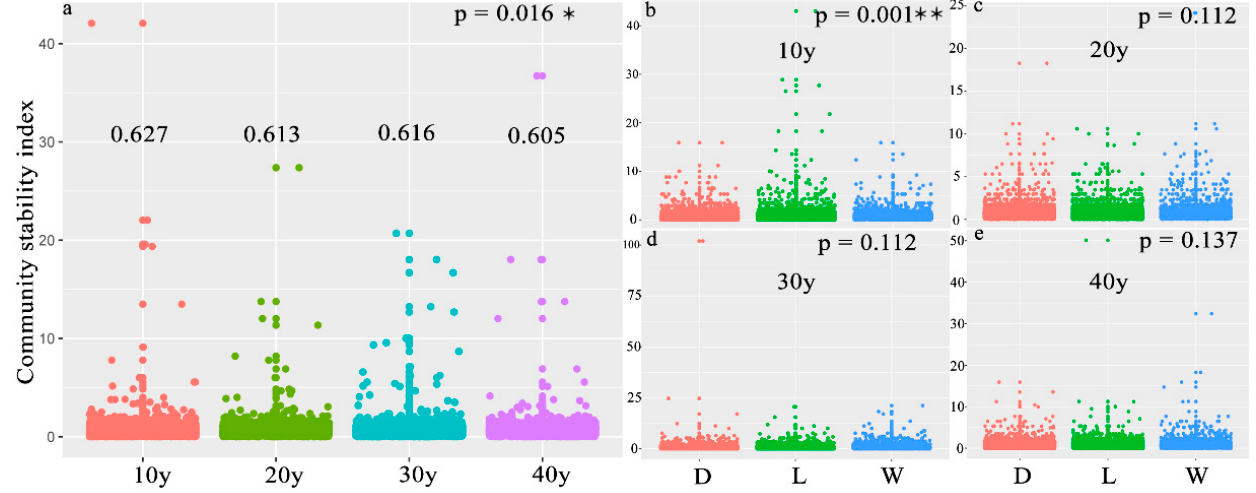
Figure 2. ( a – e ) Boxplot of the assemblage stability index in the different recovery periods or different seasons. ( a ) differenct recovery time, ( b ) 10 y, ( c ) 20 y, ( d ) 30 y, ( e ) 40 y. (The p value indicates the significance of ANOVA between the four recovery times or the three sampling seasons. * and ** represent p < 0.05 and p < 0.01, respectively. D: dry season, L: level season; W: wet season).